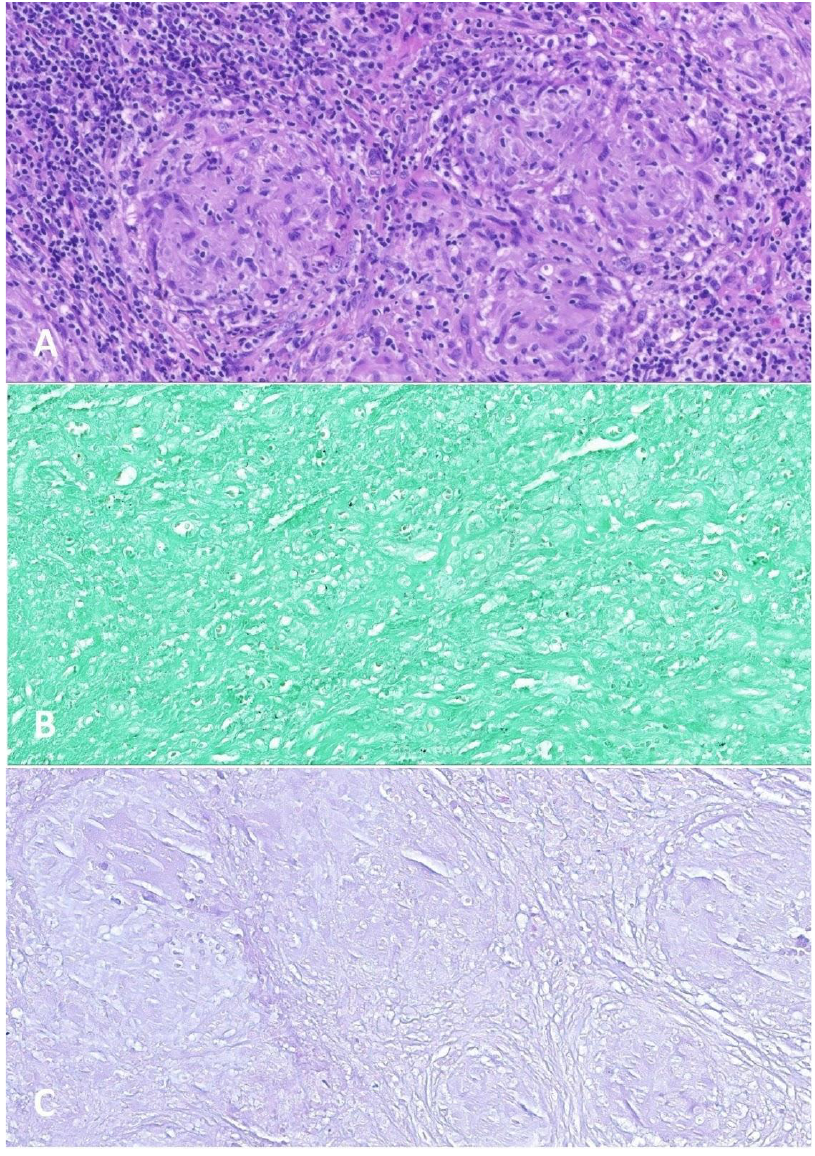
Figure 5. Small lymph nodes excised after Pre-Phase COP, 2 R-COPADM courses, and 1 R-CYM course. ( A ) Hematoxylin-eosin stain: granulomas (×200). ( B ) Grocott stain: negative for fungal or-